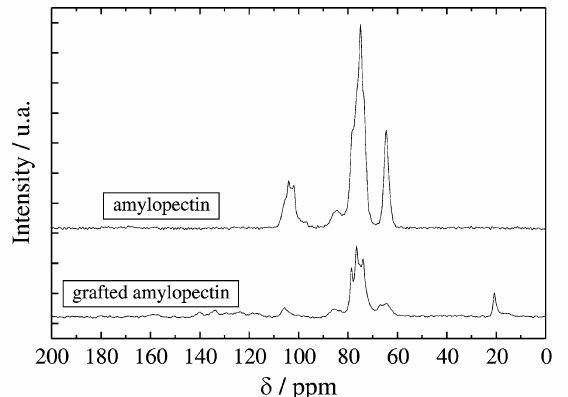
Figure 5. 13 C-NMR CP/MAS spectra of pure and grafted amylopectin- rich